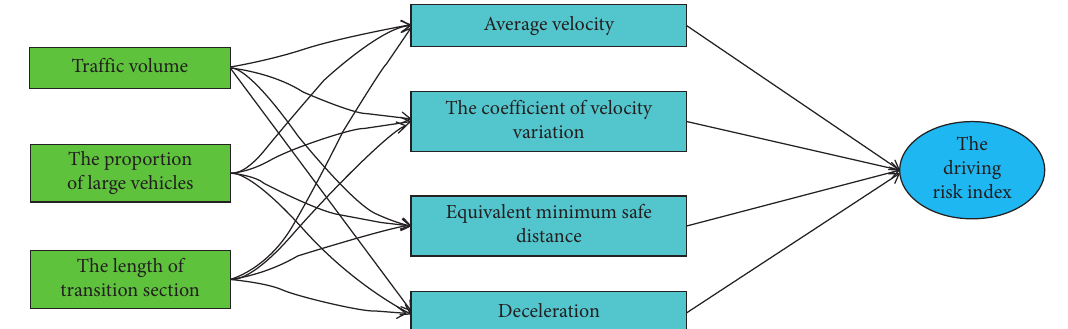
Figure 2: Schematic diagram of traffic risk analysis for rightward zone. Table 1: Length of each section of the work